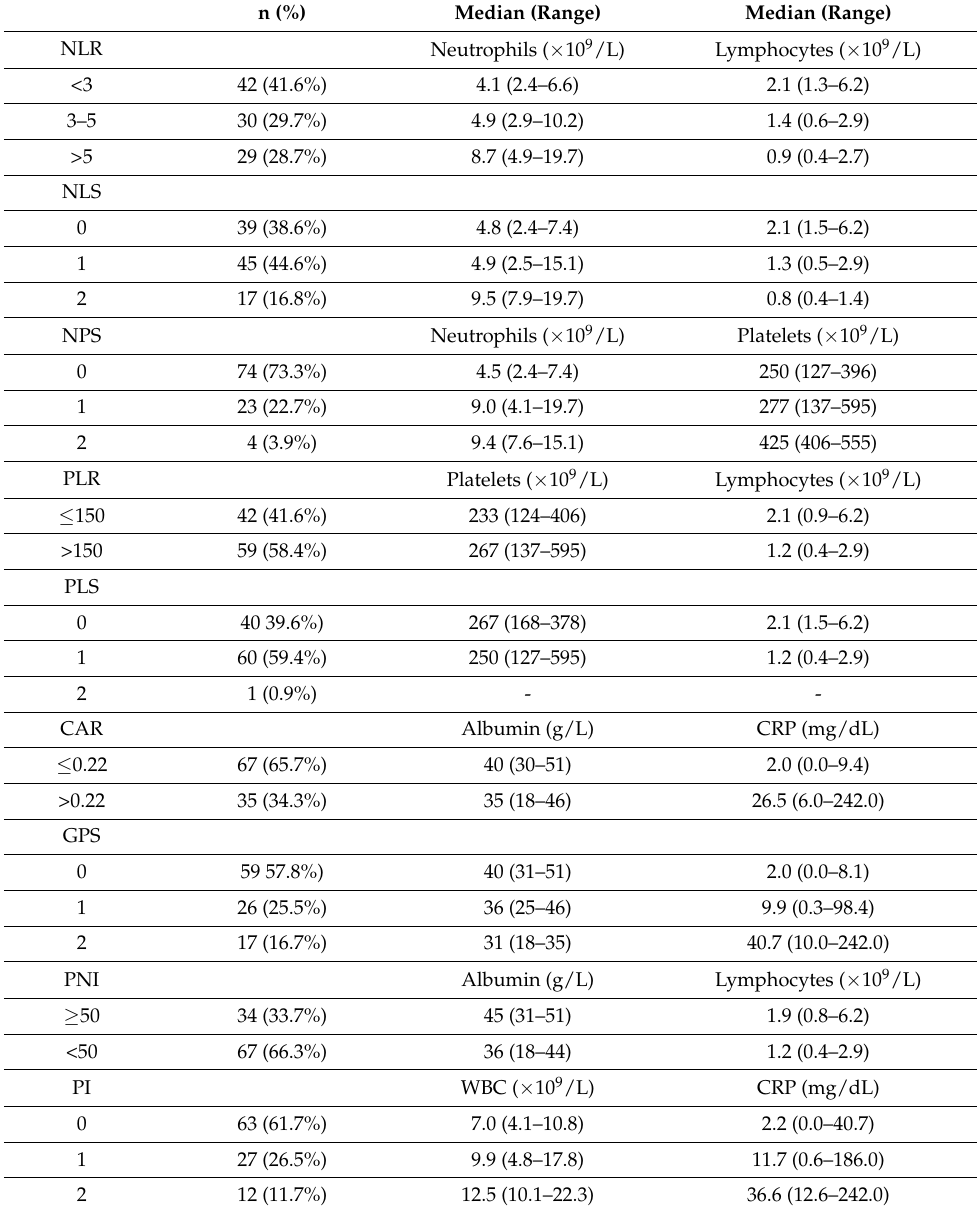
Table 3. The relationship between composite ratios and cumulative scores and their component values in GEP-NEN (n =